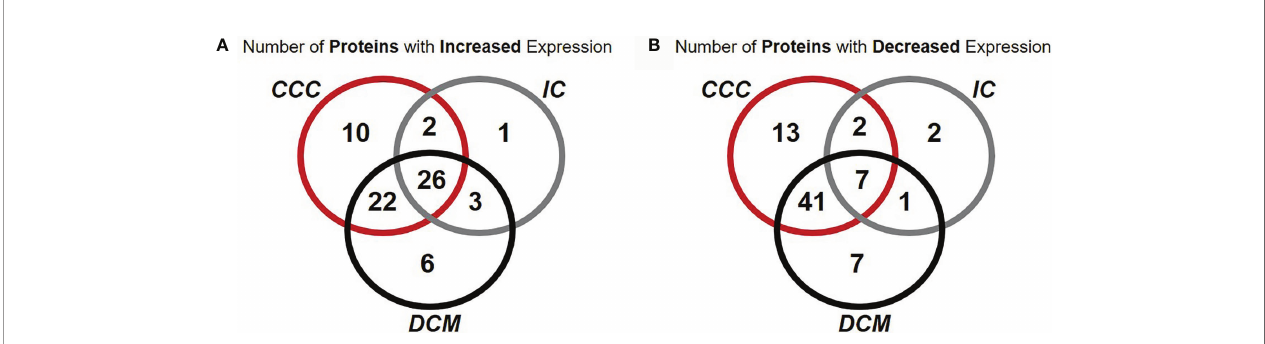
FIGURE 1 | Venn diagrams representing the occurrence of proteins differentially expressed in common or unique relationships between groups of patients with cardiomyopathy group compared with individuals without cardiomyopathies. Number of proteins with increased (A) or decreased (B) expression of at least one spot in samples from patients when compared with samples from subjects without cardiomyopathy. Over 67% of proteins differentially expressed in CCC were contained in a single